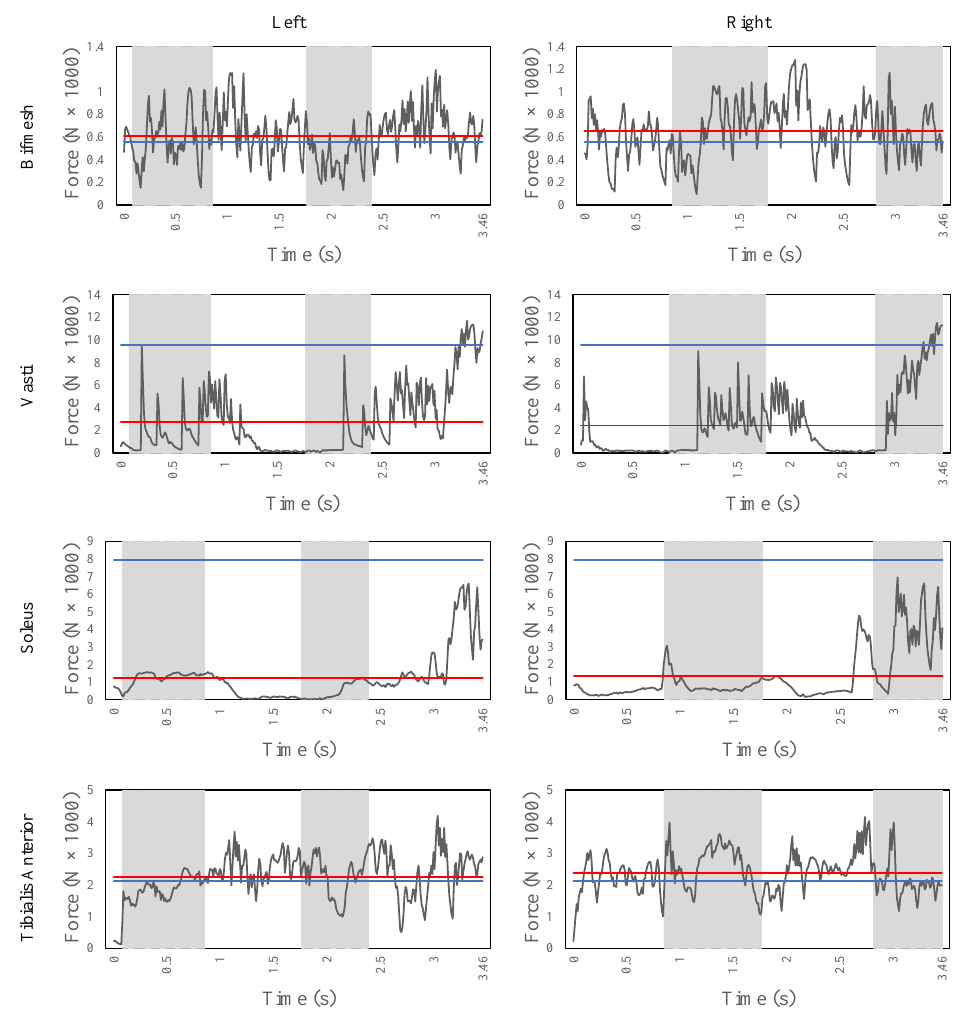
Figure 7. The muscle fiber forces of the biceps femoris, vasti, soleus, and tibialis anterior (from top to bottom) of the human model during stair ascent for the entire simulation time. The figures on the left side refer to the left leg, while the ones on the right side refer to the right leg. The horizontal red line indicates the mean fiber force, while the horizontal blue line indicates the maximum isometric forces. Figure 8 shows the ground reaction forces in the Y direction, computed at the zero moment point of each foot during two complete gaits (i.e., each foot is in contact with the ground twice and is lifted twice). The Y-component shows a peak at the very beginning and at the end of the contact. It maxes out at a force of − 1602 N on the left and − 1387 N on the right leg. It has an average (not including zeros) of − 500 N on the left leg and − 580 N of the right leg.